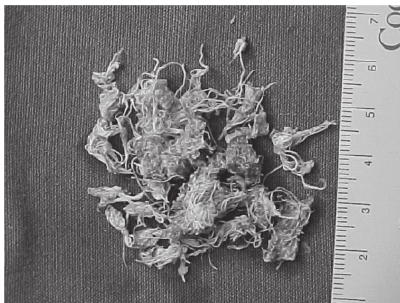
Figure 3 - Calcified surgical gauze fragments removed by percutaneous